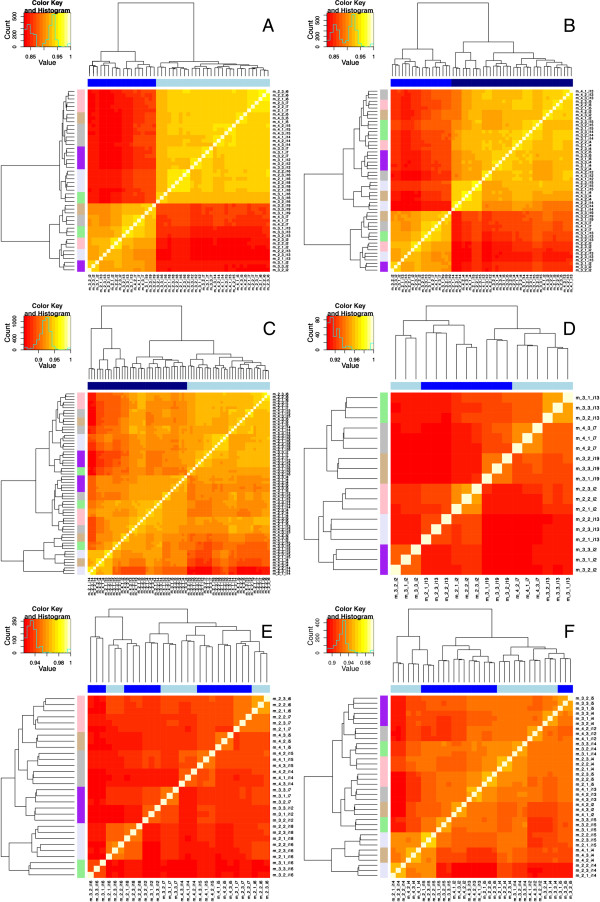
Correlation of milk and mammary transcriptomes. Each square in the heatmap represents the pairwise correlation of the sample listed in the row compared with the sample listed in the column. The shades of blue across the top of each heatmap correspond to sample type. The colors on the left side of each heat map correspond to each individual monkey. Both biological and technical replicates are shown. All technical replicates appear as clustered triplets in the dendograms. (A) Milk fat vs mammary biopsy samples; dark blue denotes biopsy, light blue denotes milk fat. (B) Milk cells vs mammary biopsy samples, dark blue denotes milk cell, light blue denotes milk fat. (C) Milk cells vs milk fat samples, dark blue denotes milk cell, blue denotes biopsy. (D) Mammary biopsy samples at day 30 and day 90. (E) Milk fat samples at day 30 and day 90. (F) Milk cells samples at day 30 and day 90. (D–F) Dark and light blue distinguish day 30 and 90 samples.